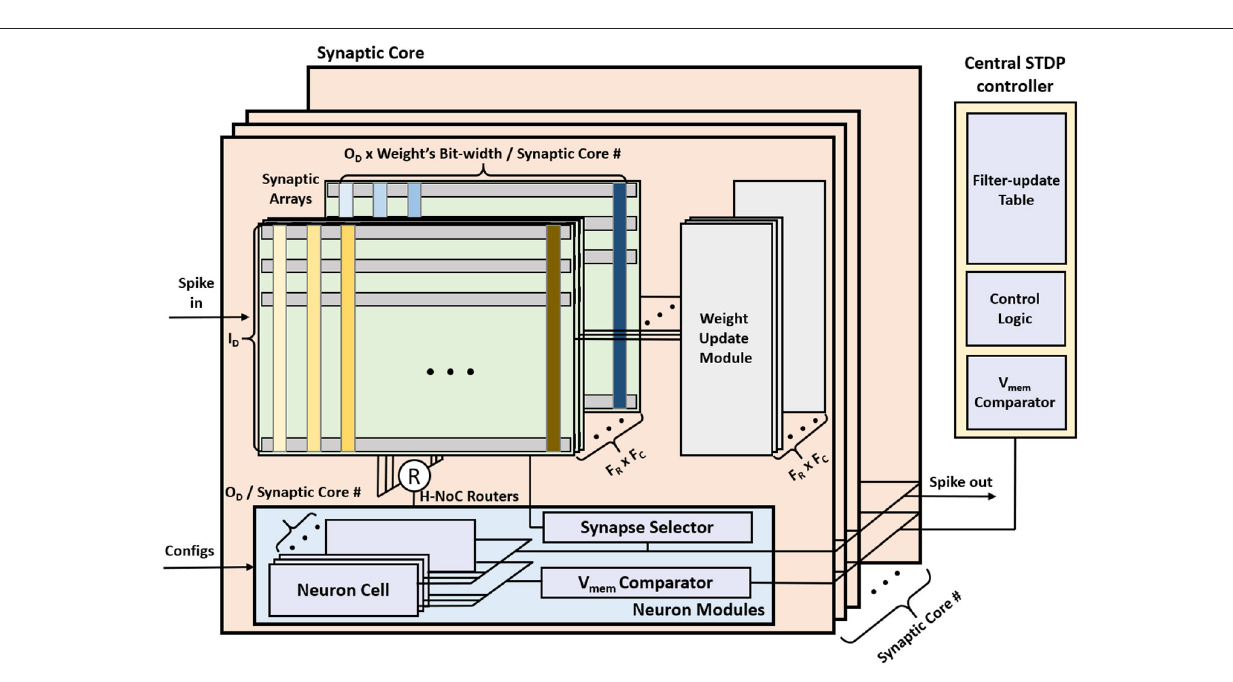
FIGURE 7 | The MONETA system architecture